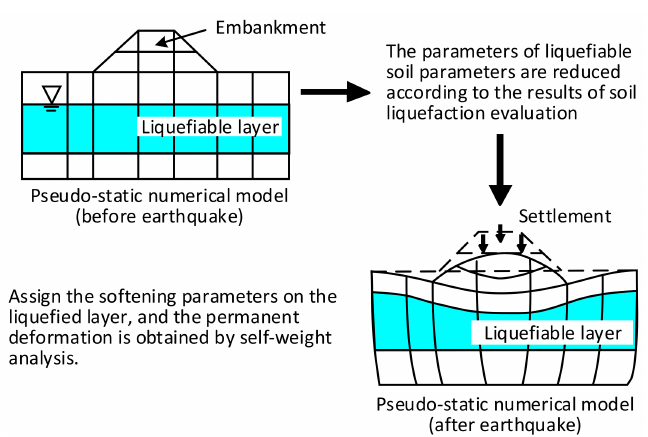
Figure 7. The concept of the static softening method